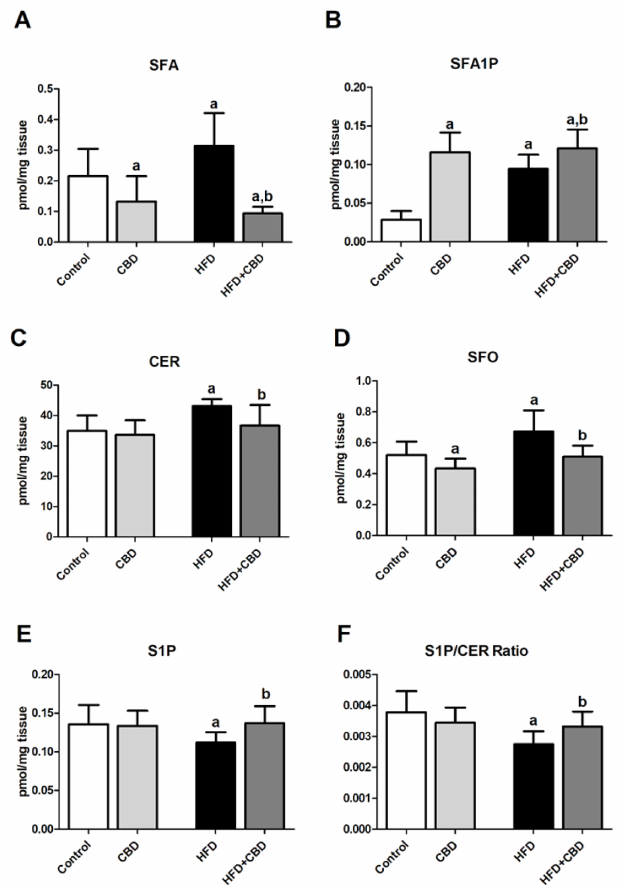
Figure 1. Intramuscular content of di ff erent components of sphingolipid pathway in rats after chronic cannabidiol (CBD) treatment, i.e., ( A ) sphinganine (SFA), ( B ) sphinganine-1-phosphate (SFA1P), ( C ) ceramide (CER), ( D ) sphingosine (SFO), ( E ) sphingosine-1-phosphate (S1P), and ( F ) sphingosine-1-phosphate / ceramide ratio (S1P / CER Ratio) in the red gastrocnemius muscle of rats fed a standard diet (control group) or high-fat diet (HFD). The data are expressed as mean values ± SD, n = 10 in each group. a p < 0.05 significant di ff erence: control group vs. examined group; b p < 0.05 significant di ff erence: HFD vs. HFD +